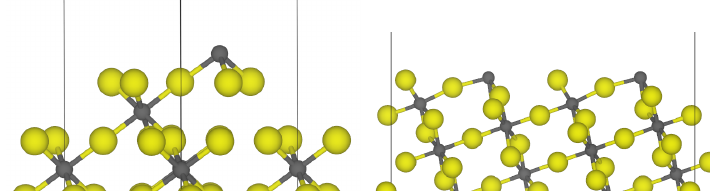
Figure 6. Optimized structure of the α -AlF 3 - ( 0001 ) surface ( left ) and optimized structure of the α -AlF 3 -10¯12 surface ( right ). Grey = aluminum, yellow =